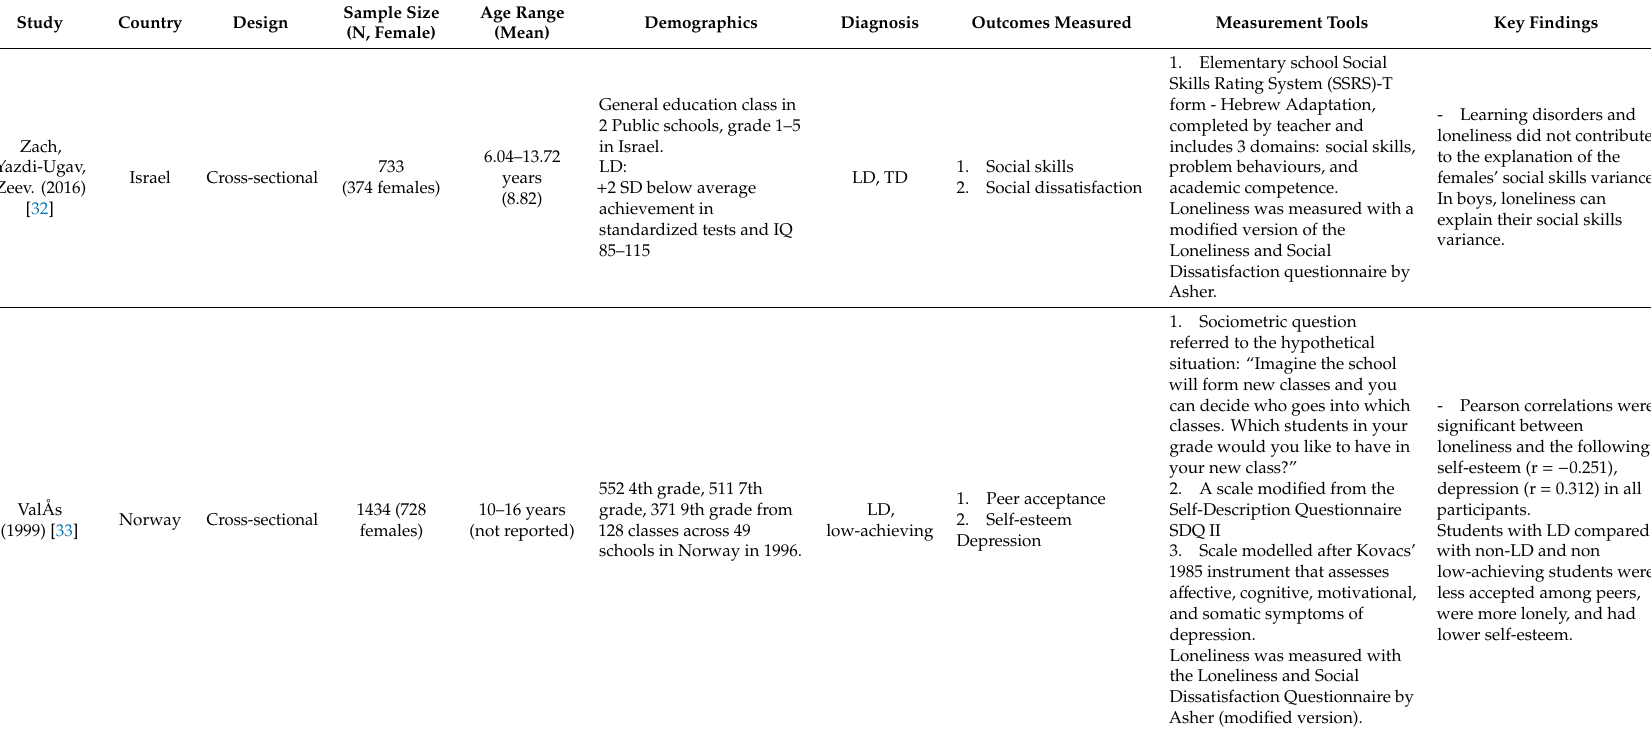
Table 1. Summary of included